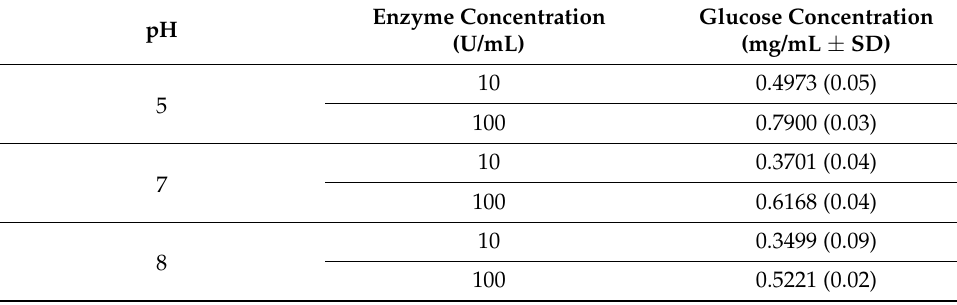
Table 1. Glucose release from the hydrolysis of cellulose using CEL. Enzyme Concentration pH